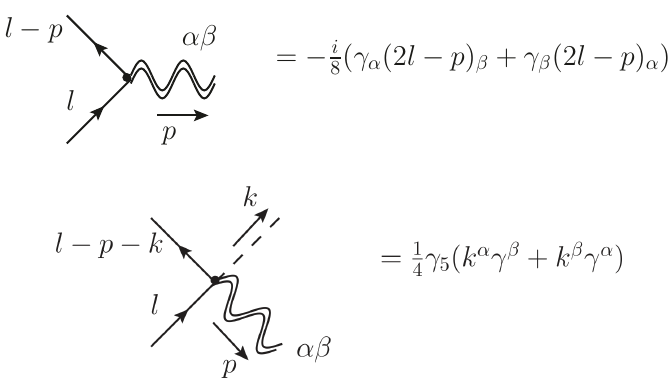
Figure 3 . Feynman rules for fermion-graviton, and axion-fermion-graviton interaction vertices.